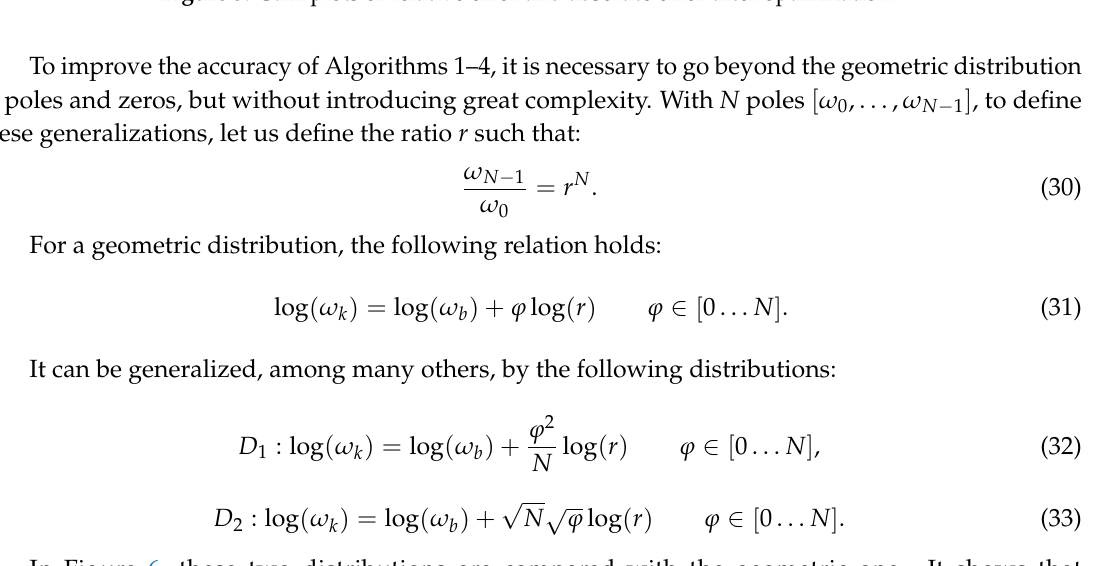
Figure 5. Gain plots of relative error and absolute error after optimization.